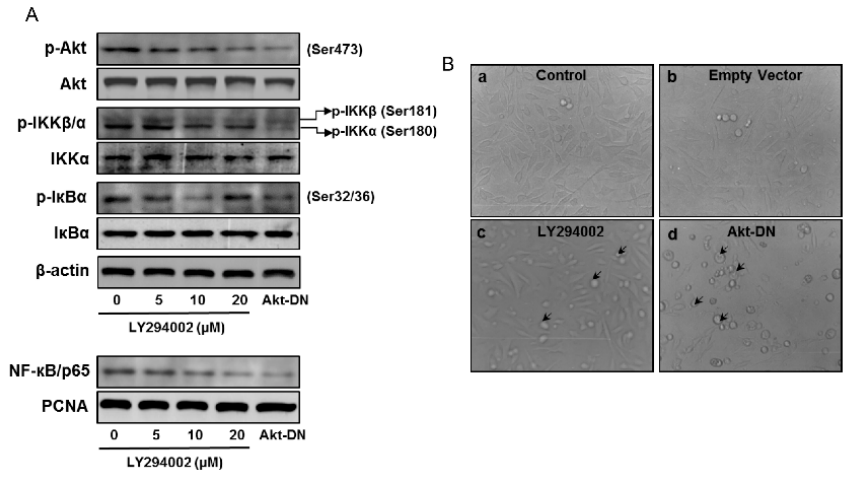
Figure 6. Effect of Akt inhibition on the expression of p-Akt (Ser473), Akt, p-IKK α / β , IKK α , p-I κ B α , and I κ B α in the total cell lysate and NF- κ B/p65 in the nuclear fraction of RWPE1 cells. ( A ) Western blotting analysis in RWPE1 cells after treatment with Akt inhibitor, 5–20 µ M LY294002, and transient knockdown of Akt using a dominant negative Akt (Akt DN) approach. β -actin and PCNA were used as internal loading controls. ( B ) Light microscopy of RWPE1 cells after treatment with LY294002 for 8 h, then Akt-DN vector and empty vector for 24 h. Arrows indicate cells undergoing apoptosis. Details are provided in the Materials and Methods